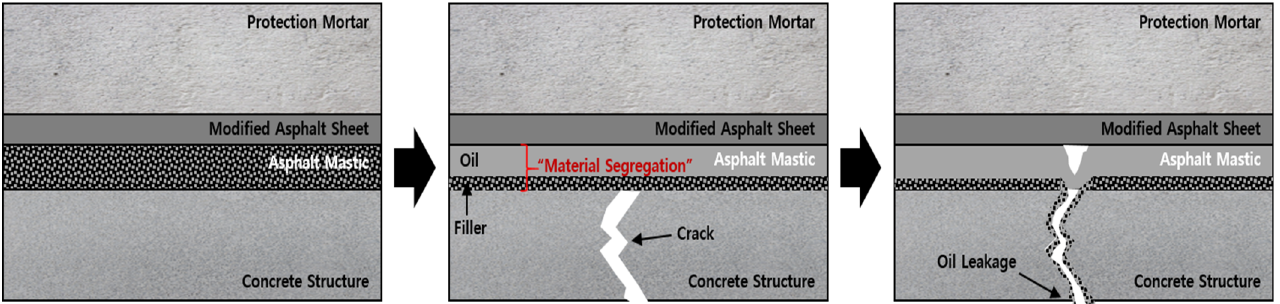
Figure 2. Oil leakage mechanism of asphalt mastic.